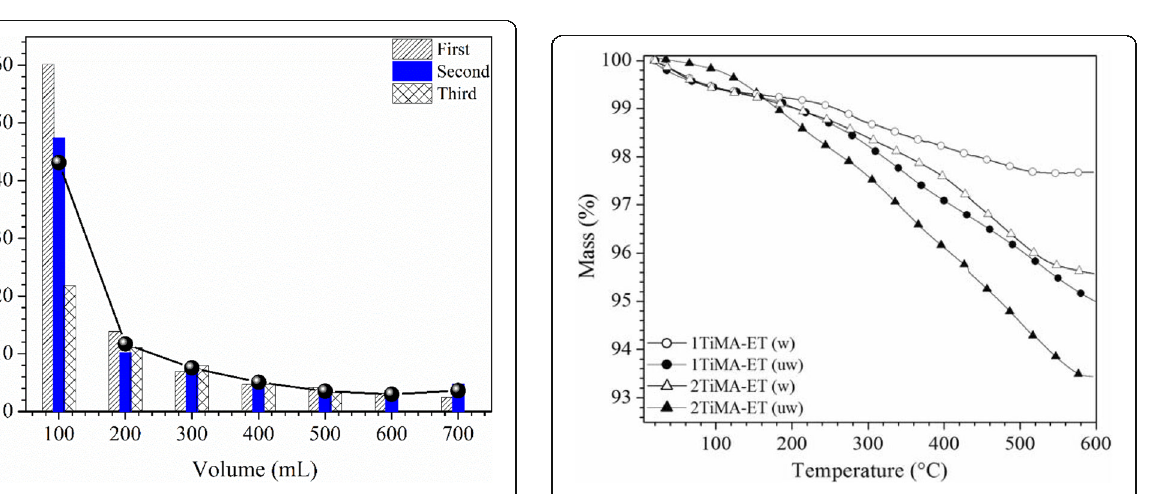
Fig. 1 TOC analysis of residual water used in washings of the sample 2TiMA-ET